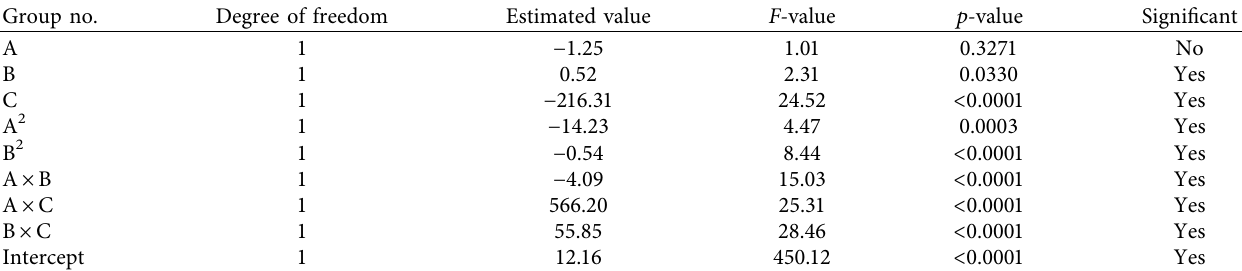
Table 6: Fitted quadratic equations of weight loss after 120 salt freeze-thaw cycles at air content of (4.5 ± 0.5)%. Group no.